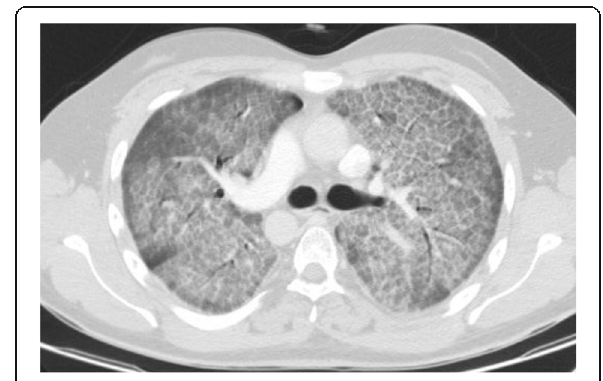
Fig. 6 Pulmonary alveolar proteinosis: thin section CT shows bilateral GGO and reticulation (crazy-paving appearance)